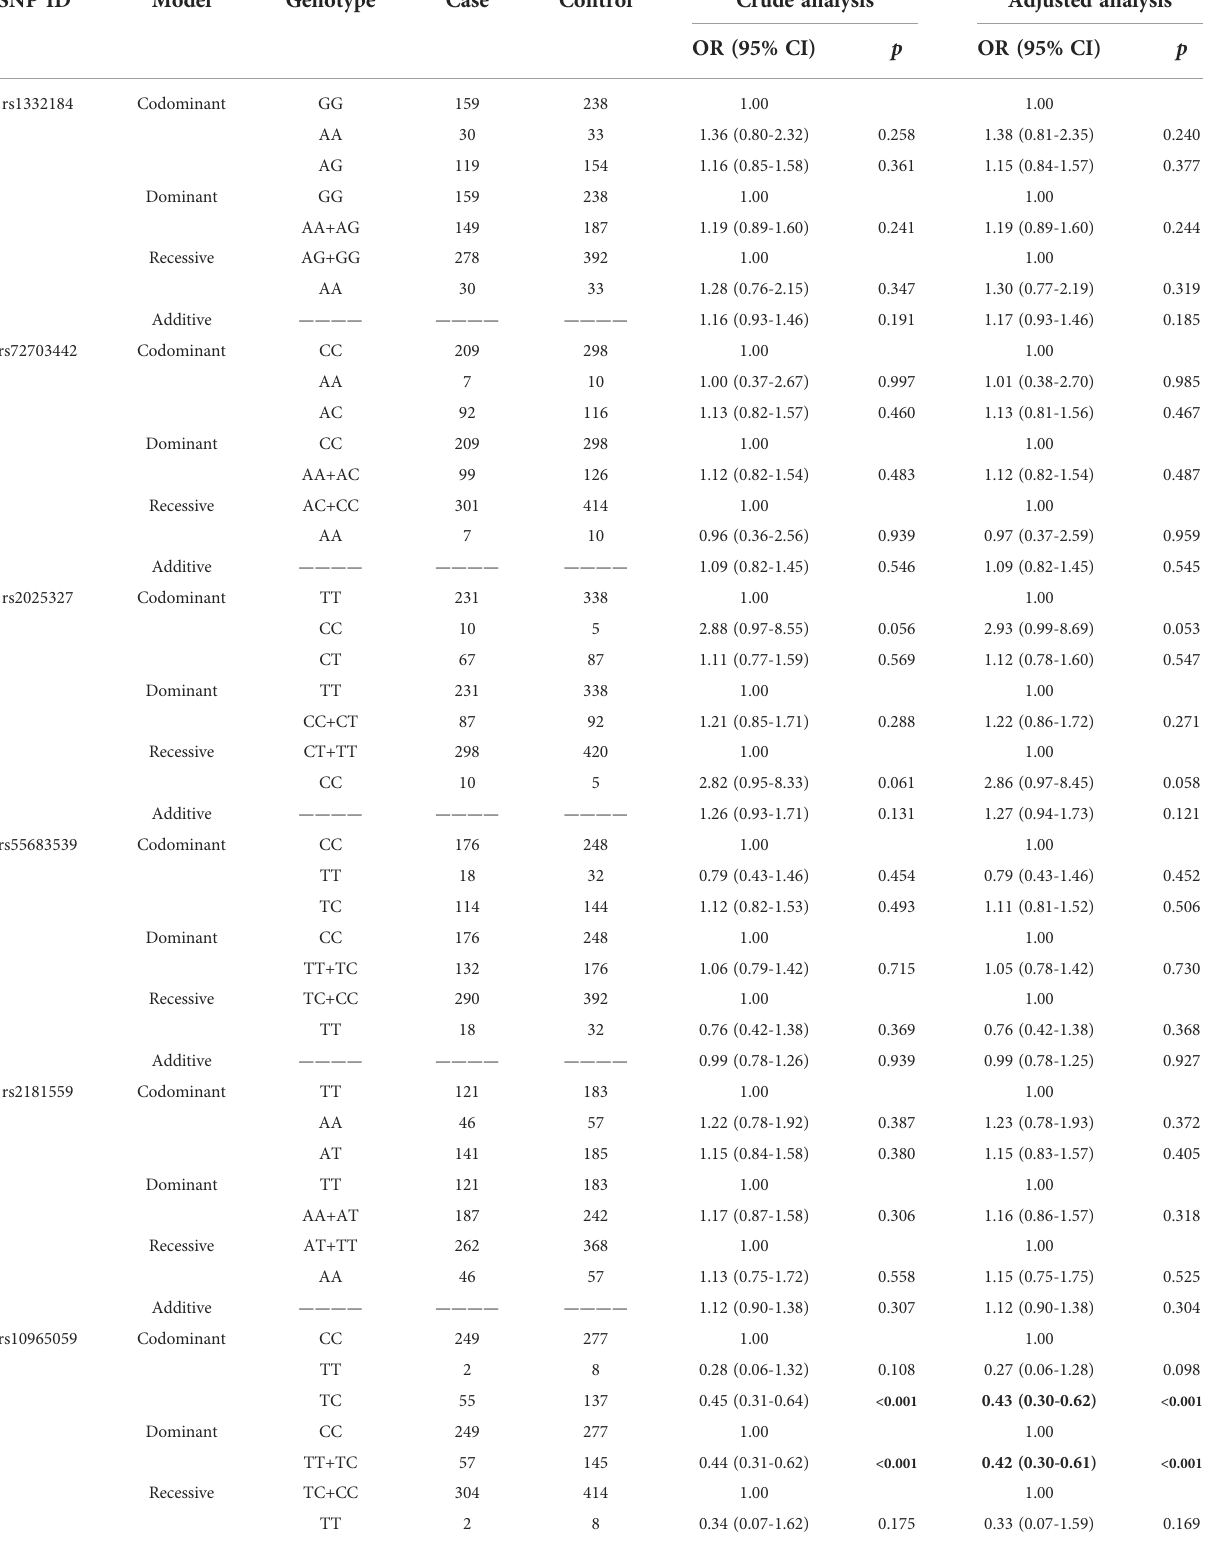
TABLE 3 Association of MIR31HG polymorphisms with alcohol-induced